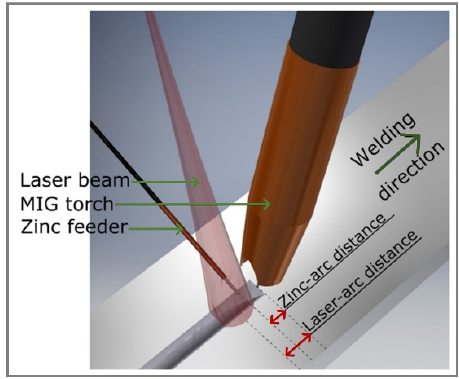
Figure 17. Schematic of WLAAM FGMs with a gradient from 316L stainless steel to nickel–aluminium bronze (NAB) by